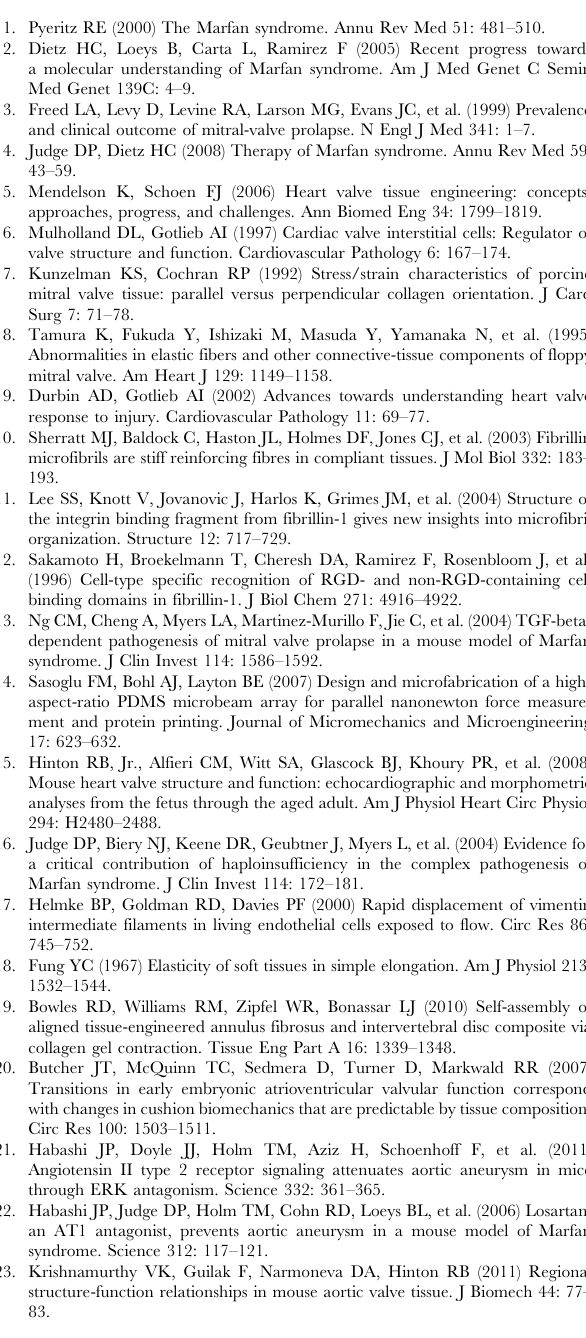
Figure S6 Fiber alignment analysis of + / + Fbn1 and C1039G/ + Fbn1 at 4 months. (A) Representative fiber-alignment curve as defined by the Fourier-Transform. (B) Fiber-alignment curves were modeled as a linear fit and the negative slope was used for comparison. Error bars show 6 SD, n $ 6. Asterisks signify statistical differences according to a Student’s t-test (p #